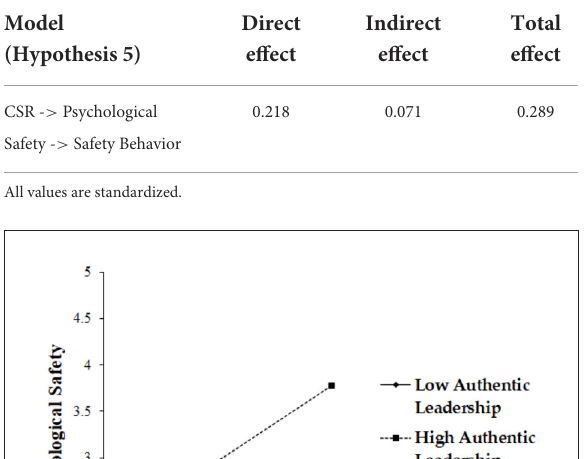
TABLE 4 Direct, indirect, and total effects of the final research model.